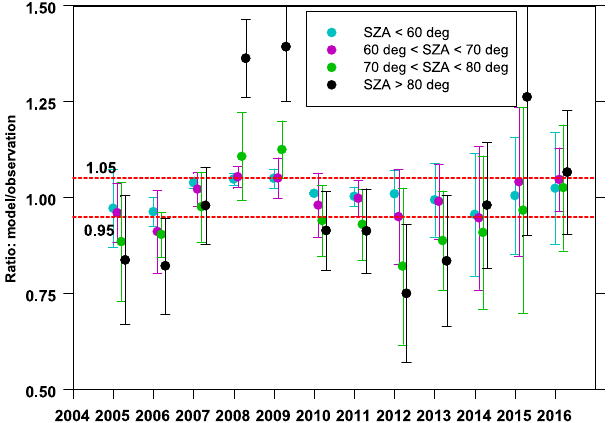
Figure 4. Radiative model simulations of daily erythemal doses for clear-sky conditions in 1996 using observed total ozone, surface albedo, and extreme high and low monthly aerosol optical thickness derived from all CIMEL Sun photometer measurements at Horn- sund in the period 2004–2016. Uncertainty is calculated as the dif- ference between the extreme daily doses expressed in percentage of the mean daily